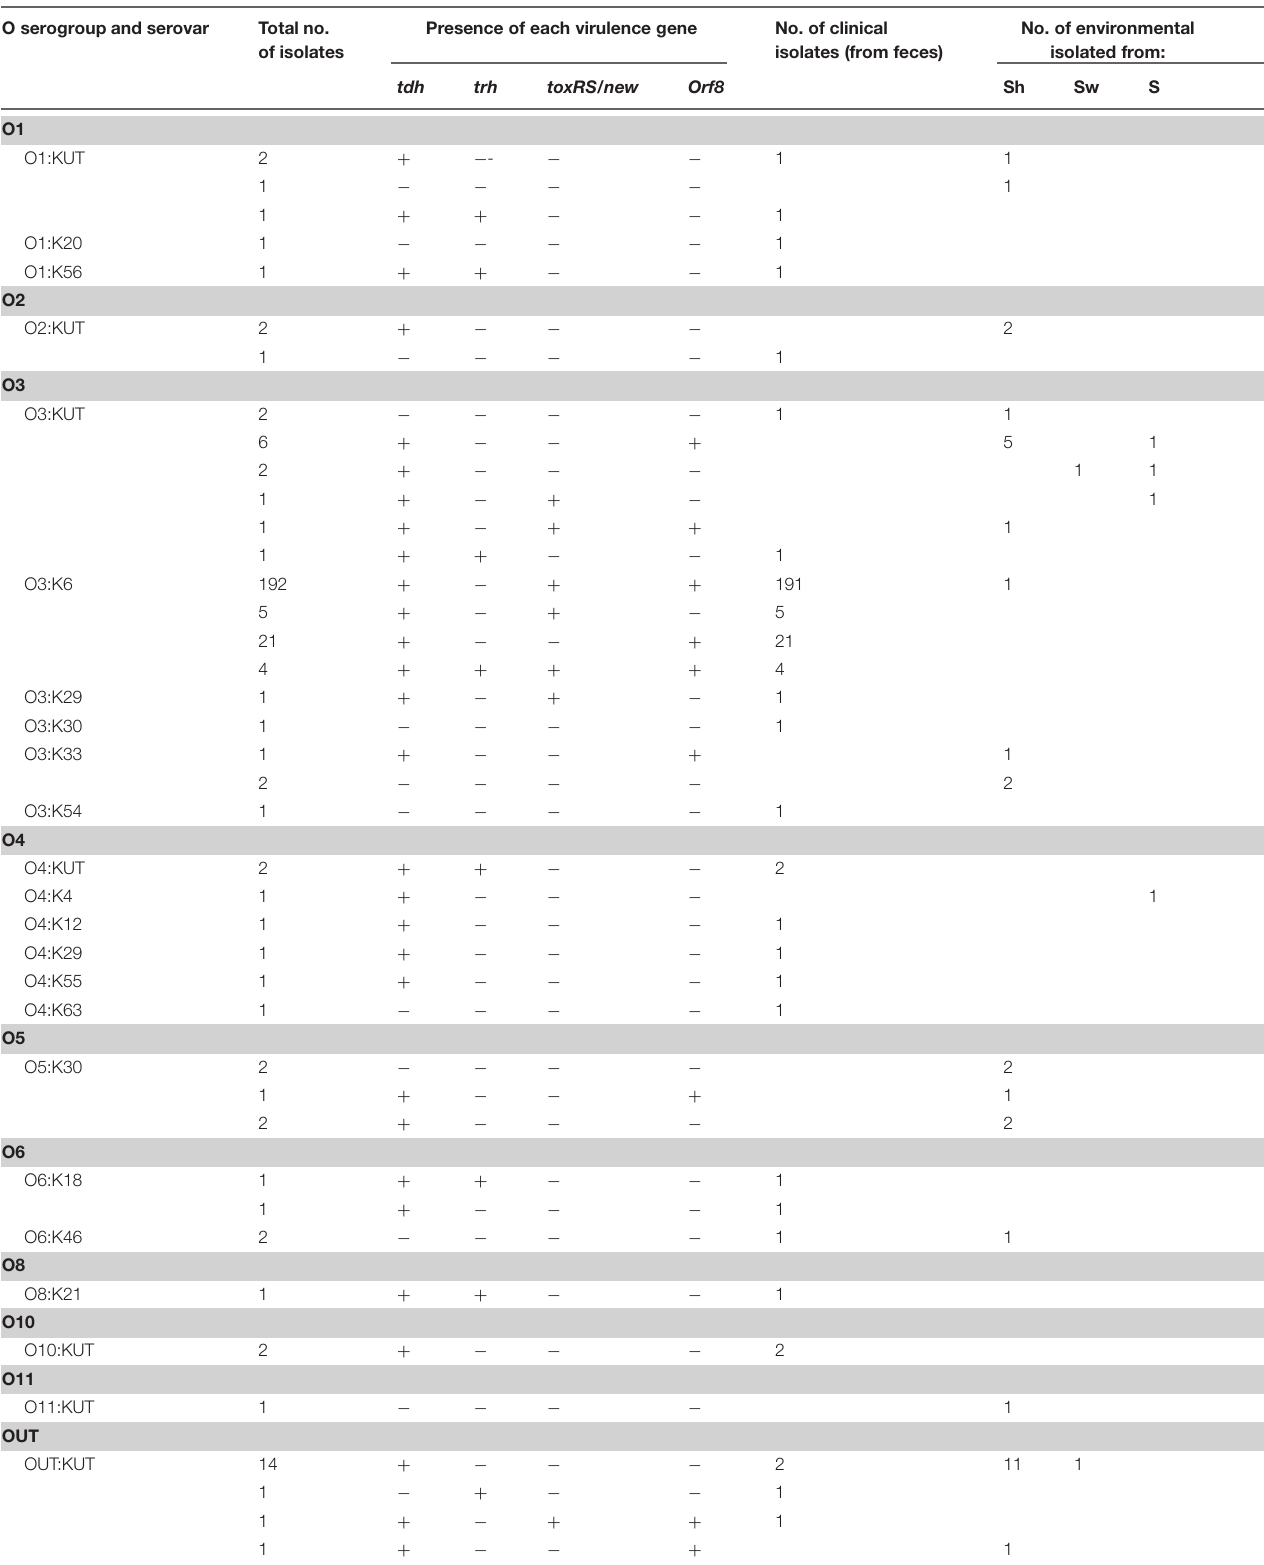
TABLE 1 | Serovar and virulence attributes of 295 Vibrio parahaemolyticus strains isolated between 2011 and 2013. O serogroup and serovar Total no. Presence of each virulence gene No. of clinical of isolates